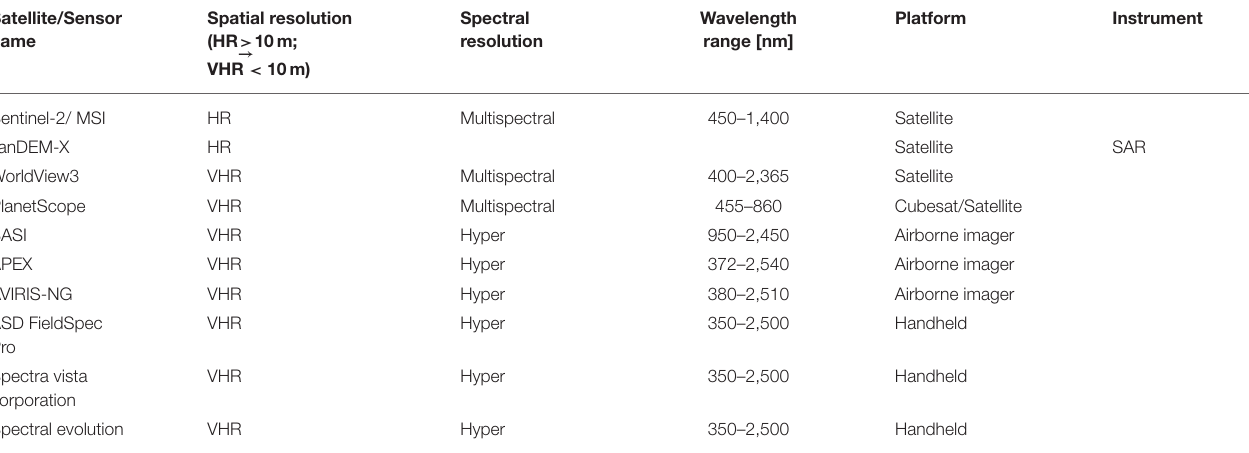
TABLE 1 | Examples of actual sensors already used for detection and/or polymer identification of plastic